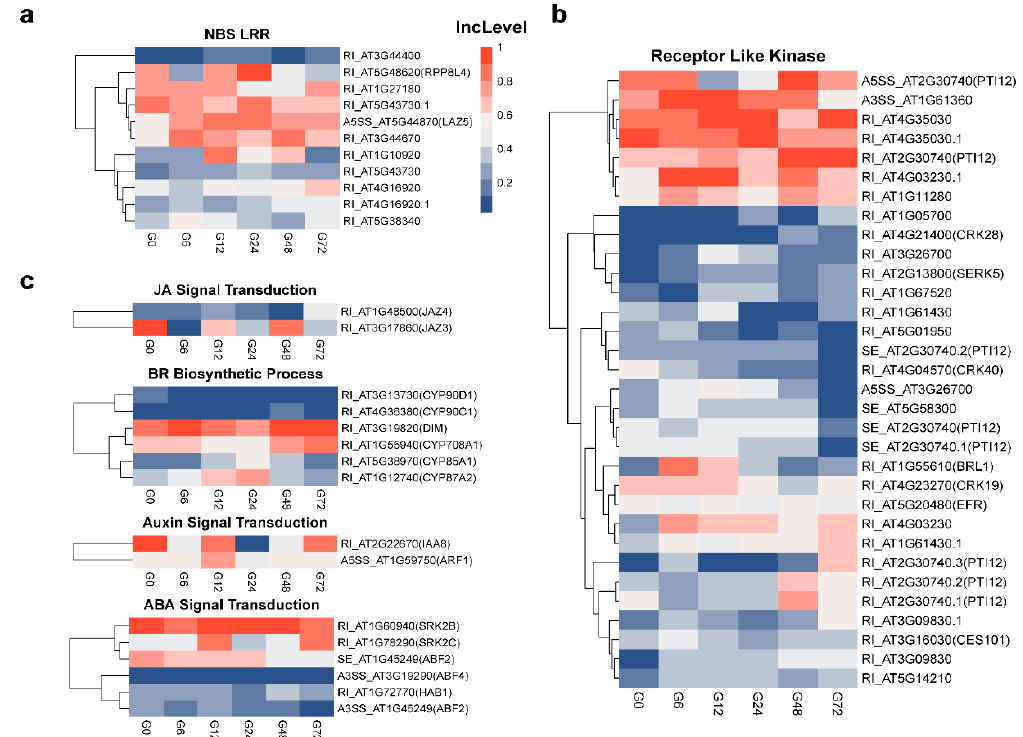
Figure 5. Clustering analysis of defense-related gene IncLevel value patterns. ( a – c ) Three groups of defense-related genes identified in DSGs, namely NBS-LRR (R genes) ( a ), receptor-like kinase (RLK) ( b ) and plant hormone signaling or biosynthesis genes ( c ). In the heatmap, red means a high IncLevel, while blue means a low IncLevel. Event names on the right are composed of the AS type and gene locus. Different isoforms for the same gene are noted by “.1”,”.2” and so forth.